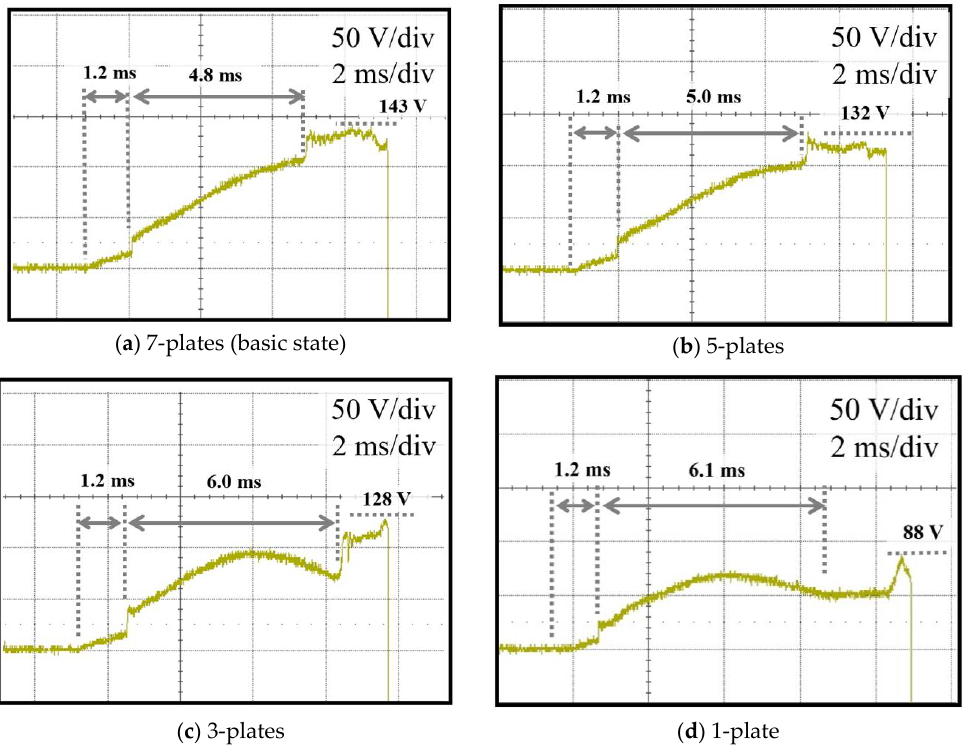
Figure 15. Experimental waveforms for cases.